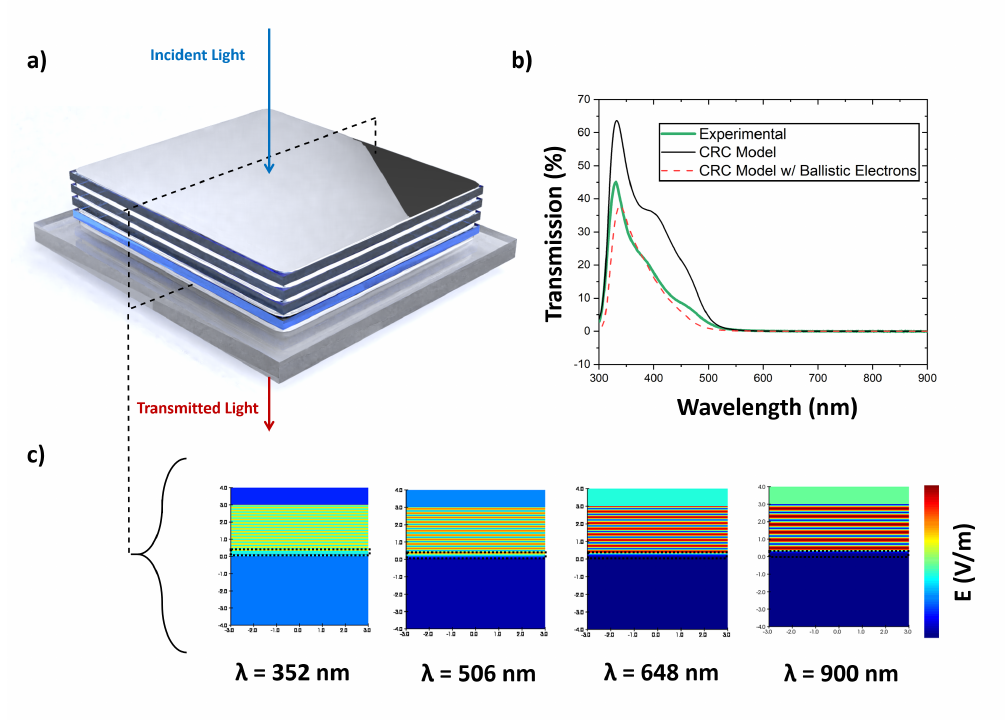
Figure 4: (a) 3D model of the MIM like substrate. (b) Experimental and simulated transmission spectrum considering the model with (dashed red line) and without (solid black line) ballistic electrons effects. (c) Electric field maps in each wave-